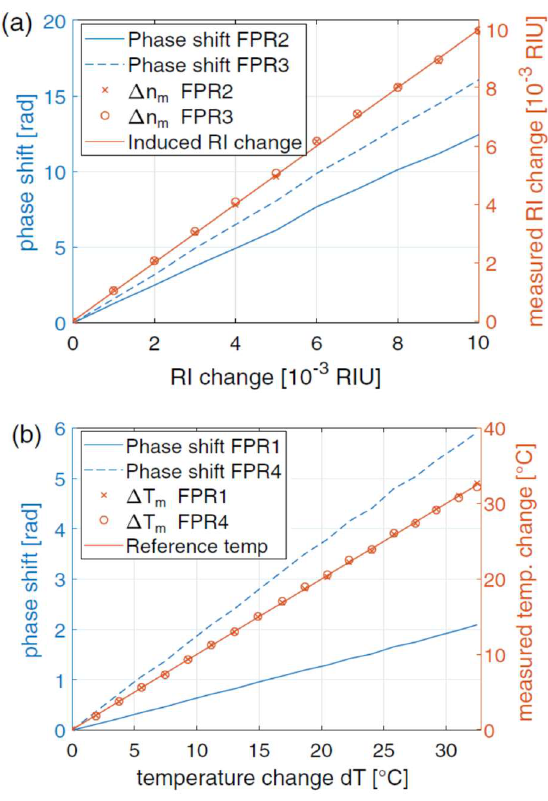
Fig. 2. (a) Response of the open cavities to a change in RI, induced with sucrose solutions. (b) Response of Si inlay and fiber piece for an induced change in